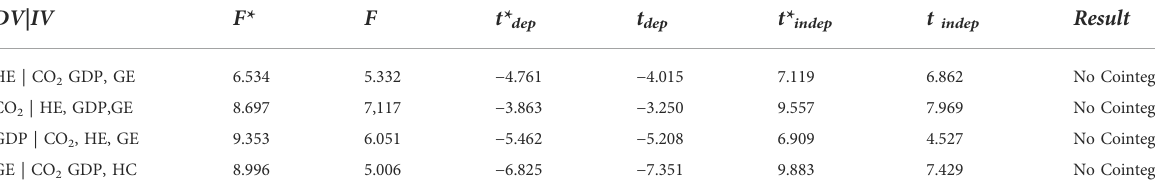
TABLE 5 Bootstrap ARDL cointegration test results.